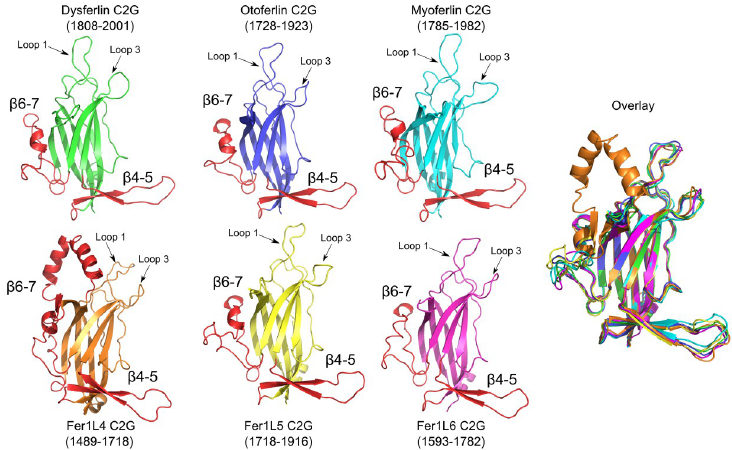
Fig 13. C2G models for dysferlin C2G (green), otoferlin C2G (blue), myoferlin C2G (cyan), Fer1L3 C2G (orange), Fer1L5 C2G (yellow), Fer1L6 C2G (magenta). The β 4–5 and β 6–7 subdomains of C2G are labeled and colored red. The superposition of all six C2G models is labeled as